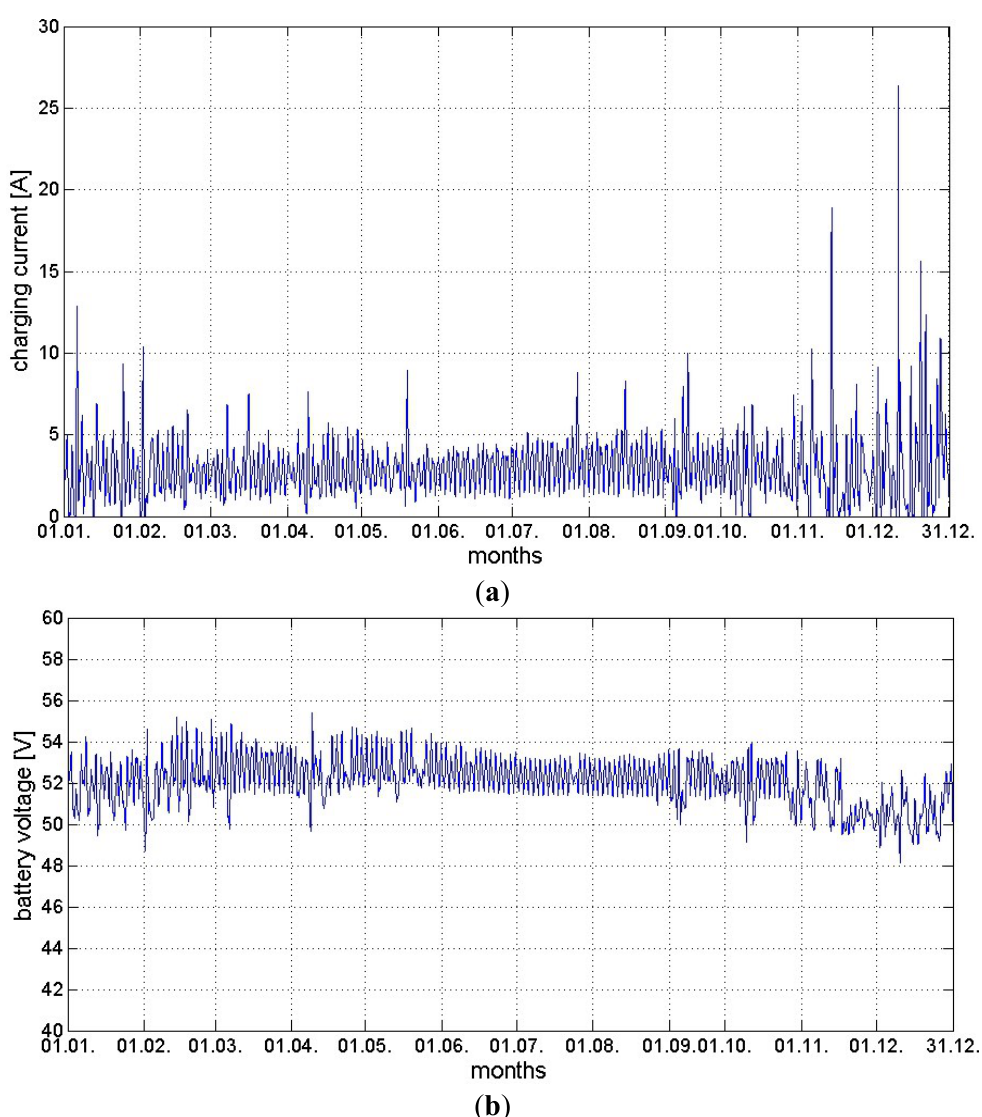
Figure 8. ( a ) Variation of charging current in case of one solar array for the BSS B during a year; ( b ) Yearly variation of battery voltage for the BSS